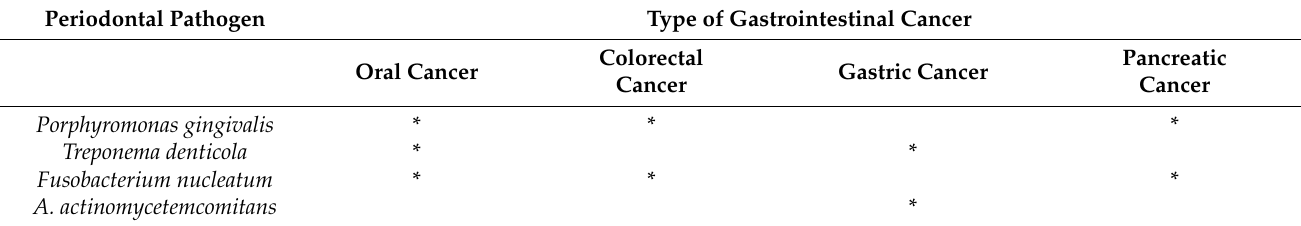
Table 1. Possible involvement of periodontal pathogens in the onset of gastrointestinal cancers. Periodontal Pathogen